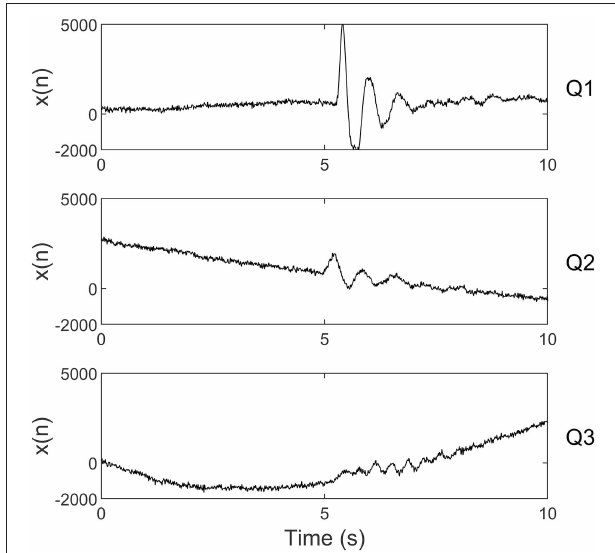
FIGURE 4 | Infrasound signals from Etna 2017 experiment, as presented to the experts during the annotation process. The assigned quality factors ( Q 1, Q 2, Q 3) is also shown. Notice that the highest quality of Q1 implies the best signal to noise ratio, with the explosion clearly distinguishable. For Q2, the